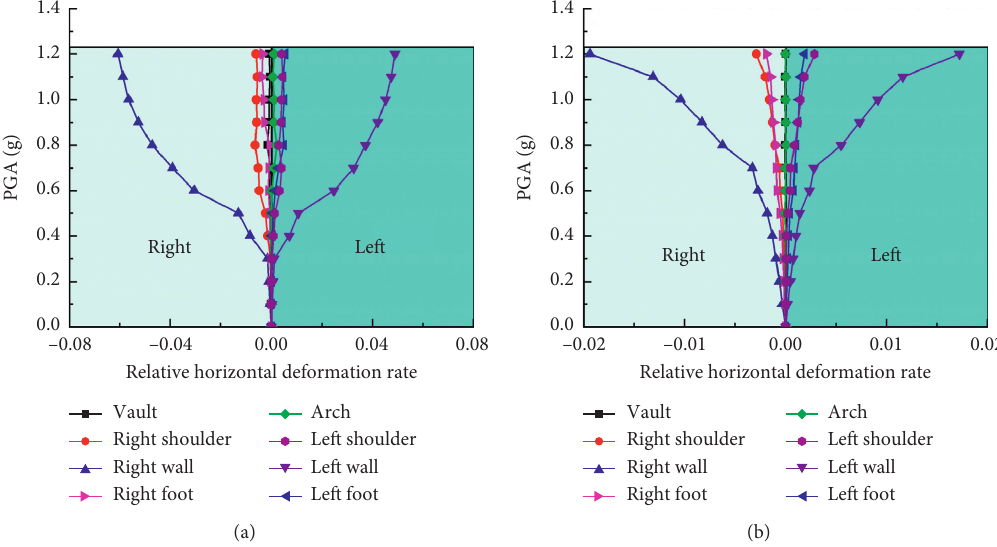
Figure 9: The vulnerable area of different characteristic locations of the tunnel section under action of different ground motions: (a) near- fault pulsed; (b) far-field.